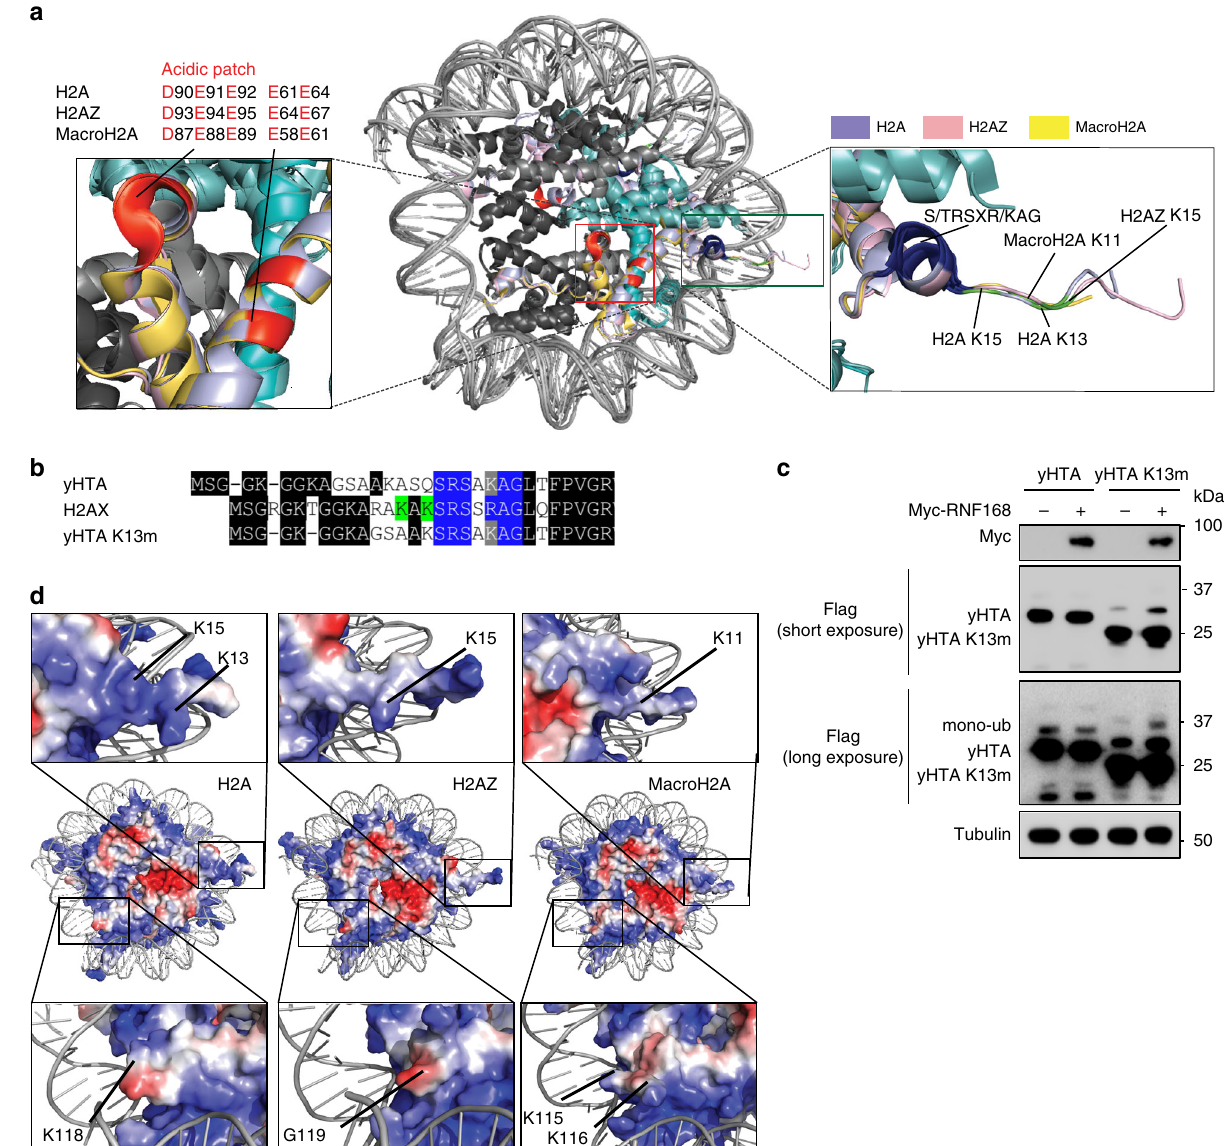
Fig. 5 Ubiquitination requirement for RNF168 selectivity on H2A variants. a Superimposition of H2A-containing, H2AZ-containing, and macroH2A- containing nucleosome illustrates the detailed residues required for RNF168-mediated site-speci fi c ubiquitination. Zoom on the acidic patch (red), alpha1- extension helix region (blue) and RNF168-targeted lysine residues (green). b Proximity restriction of RNF168-mediated site-speci fi c ubiquitination on H2A. Sequence alignment of human H2AX and yeast HTA (yHTA) at the N-terminal tail. The N-terminal sequence of the yHTA K13m mutant ( Δ ASQ) used as in c . The alpha1-extension helix residues are highlighted in blue. The proximal lysine residues are highlighted in green. c SFB-yHTA and mutant were co-transfected with Myc-RNF168 in HEK293T cells for 24 h and analyzed by western blot. Repeated three times independently with similar results. d Electrostatic potential (red-negative, blue-positive) analyses of H2A variant-containing nucleosomes. Zoomed illustration of the N-terminus and C-terminus of H2A variants. Histone tail lysines were labeled. H2AZ C-terminal lysines were absent in the illustration and G119 residue was marked. Source data are provided as Source Data fi